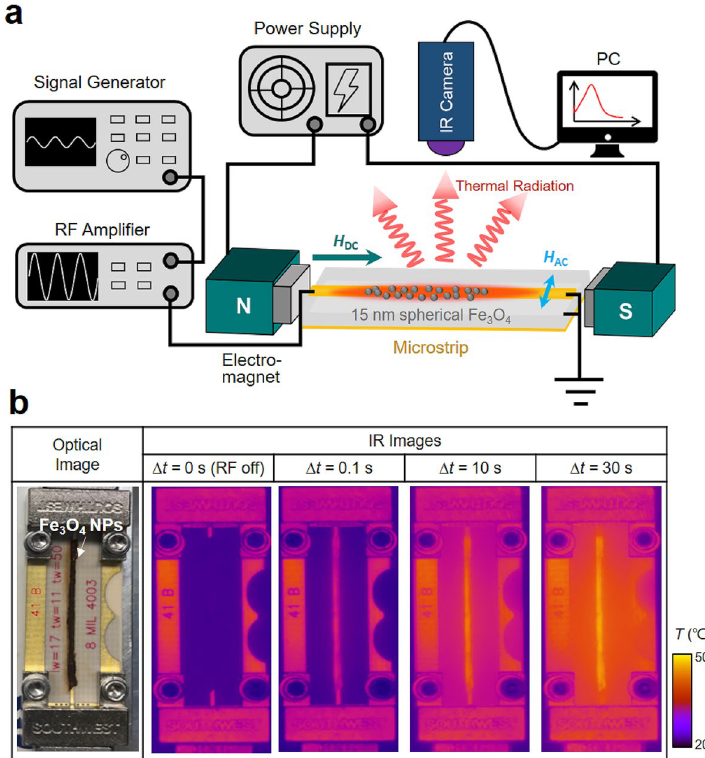
Figure 2. Experimental measurement of temperature increment from Fe 3 O 4 nanoparticles via thermal radiation. ( a ) Experimental apparatus for measurements of temperature increment by resonant spin-excitation and dissipation in superparamagnetic, 15-nm-diameter Fe 3 O 4 nanoparticles. In order to generate RF magnetic fields (by power pumping), RF currents of GHz frequencies were transmitted to the microstrip using a signal generator and an RF amplifier. A DC magnetic field was also applied on the axis of a microstrip line. The direction of the RF magnetic field was perpendicular to the DC field direction. The change of temperature of the particles was recorded by an IR camera through thermal radiation. A detailed explanation of the experimental procedure is given in Method. ( b ) Optical image (left) of sample stage and thermal IR images (right four) for different duration times ∆ t of application of RF magnetic fields (i.e. ∆ t = 0, 0.1, 10, and 30 s). The color bar on the right indicates the local